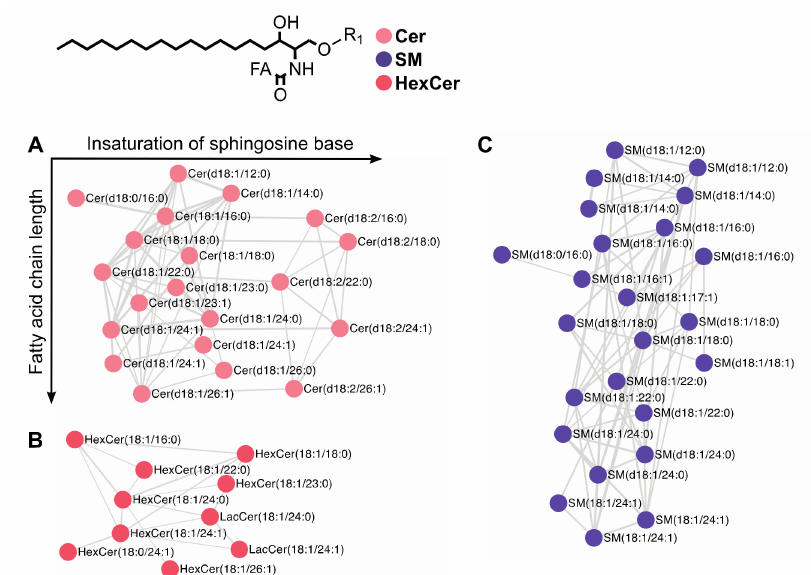
Figure 5. Lipidic molecular network of sphingolipids including commercial standards and epithelial corneal cell lipids. MN of ( A ) ceramide, ( B ) sphingomyelin, and ( C ) hexosylceramide. The MN was organized along two orthogonal axes: abscissa and ordinate corresponding to insaturation of the sphinganine base and fatty acid side chain length,